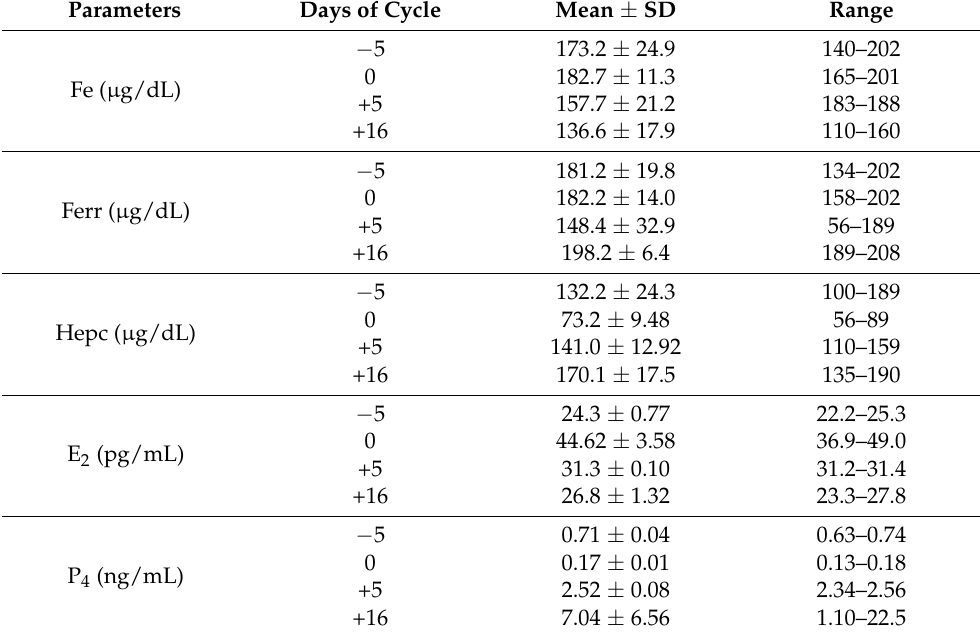
Table 1. Mean ± SD of serum iron (Fe), ferritin (Ferr), hepcidin (Hepc), 17- β estradiol (E2) and progesterone (P4) in cyclic Purebred Spanish